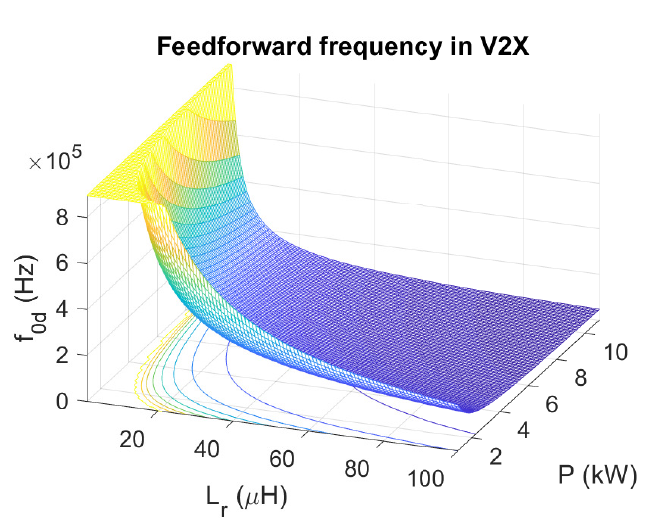
Figure 10. V2X feedforward frequency in function of L r